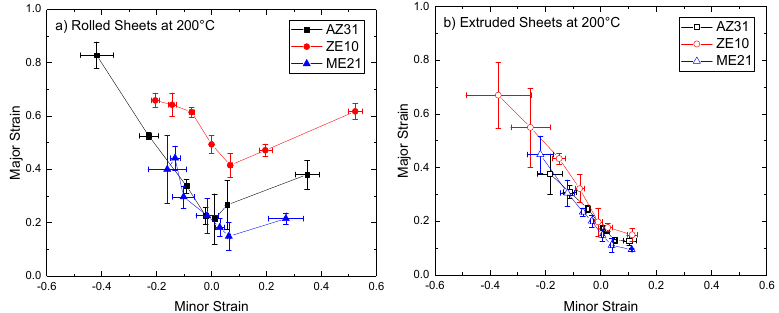
Figure 5. Forming limit diagrams for the ( a ) rolled and ( b ) extruded sheets at a temperature of 200 °C (results for AZ31 and ZE10 in ( a ) are repeated from Stutz et al. [3]).